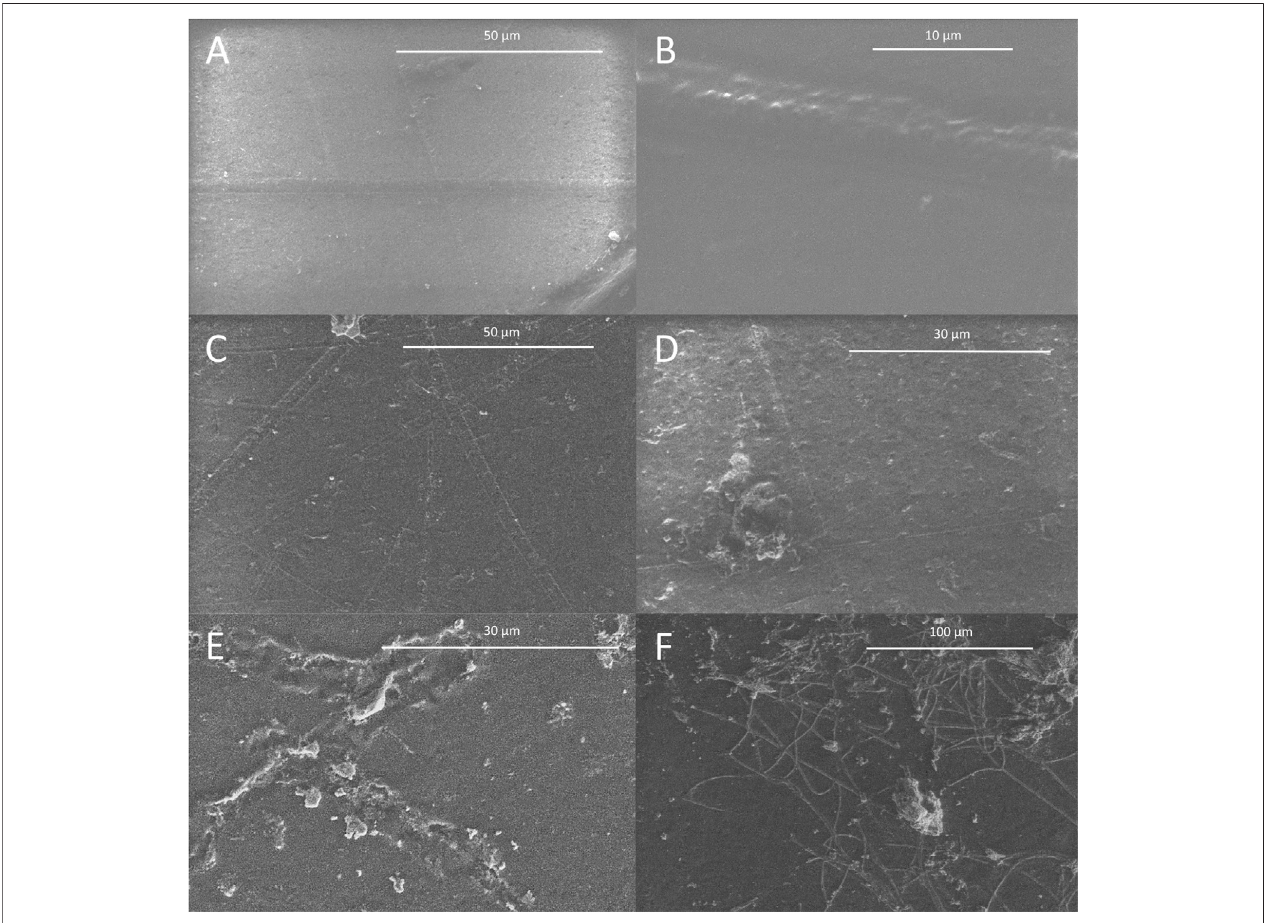
FIGURE 5 | E-SEM micrographs of reference (A,B) and exposed (C – F) PLA fi lms.